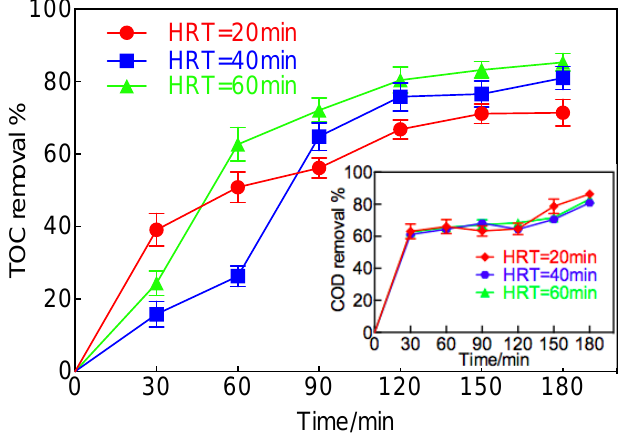
Figure 11. TOC and COD removal of RhB wastewater at different HRTs in the recycling-flow 3D electro-reactor system (RhB wastewater initial concentration is 100 mg/L; volume is 500 mL; initial pH is 7; Na 2 SO 4 as an electrolyte, initial concentration is 2 g/L; voltage is 5 V). TOC removal at different HRTs (20 min, 40 min, and 60 min) gradually increased and then reached the maximum value at the 180th min. The highest TOC removal (85.0%) at HRT = 60 min was 13.8% and 6.8% higher than the corresponding value (71.2% and 78.2%) at HRT = 20 min and HRT = 40 min, respectively. In the comparisons of TOC removal, it can be concluded that HRT = 60 min had a better removal effect.